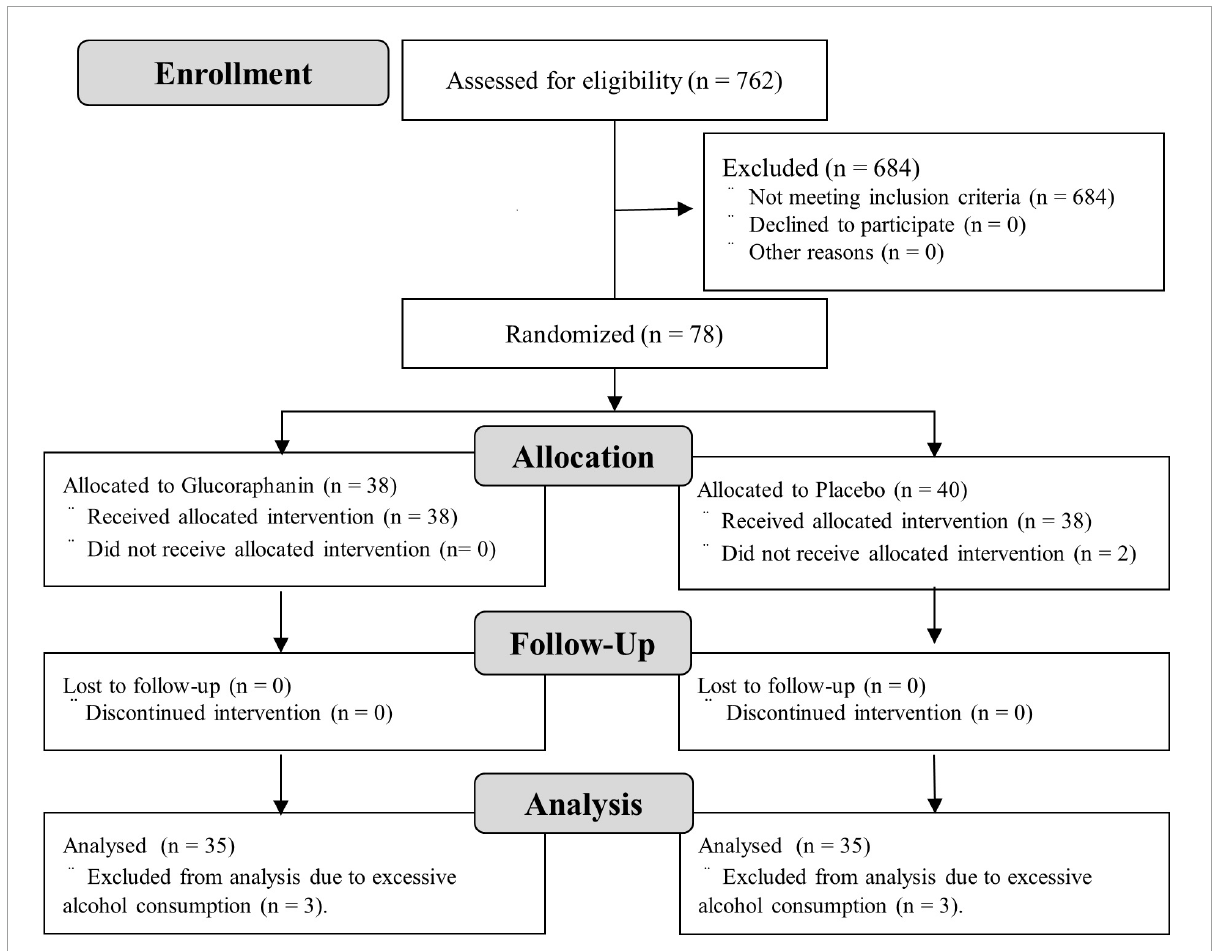
FIGURE2 Flow diagram of trial